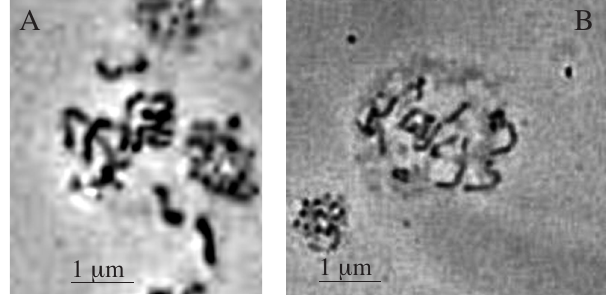
Fig 6 - Orcein-stained preparations from embryos of irradiated phyl- loxera showing: A) at dose 20 Gy: a cell with about 15 chro- mosomes which some of them are stuck together; B) at dose 30 Gy: a cell with 14 chromosomes.